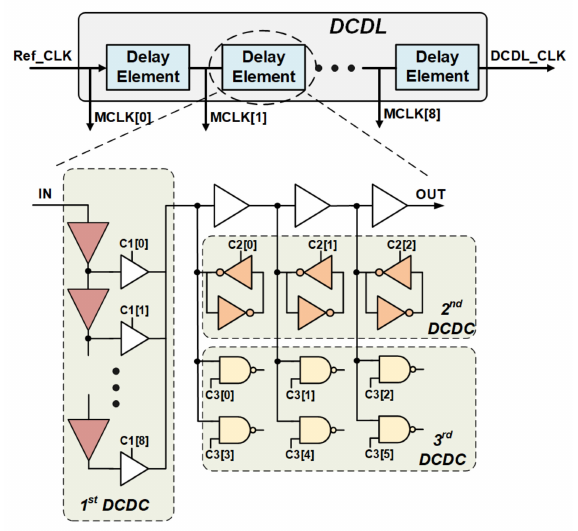
Figure 5. Circuit block diagram of DCDL.